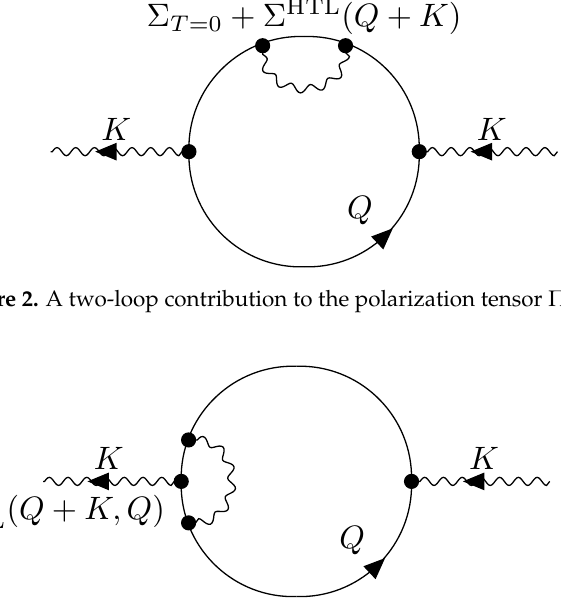
Figure 3. Another two-loop contribution to the polarization tensor Π ( 2 ) ( k 0 , k )